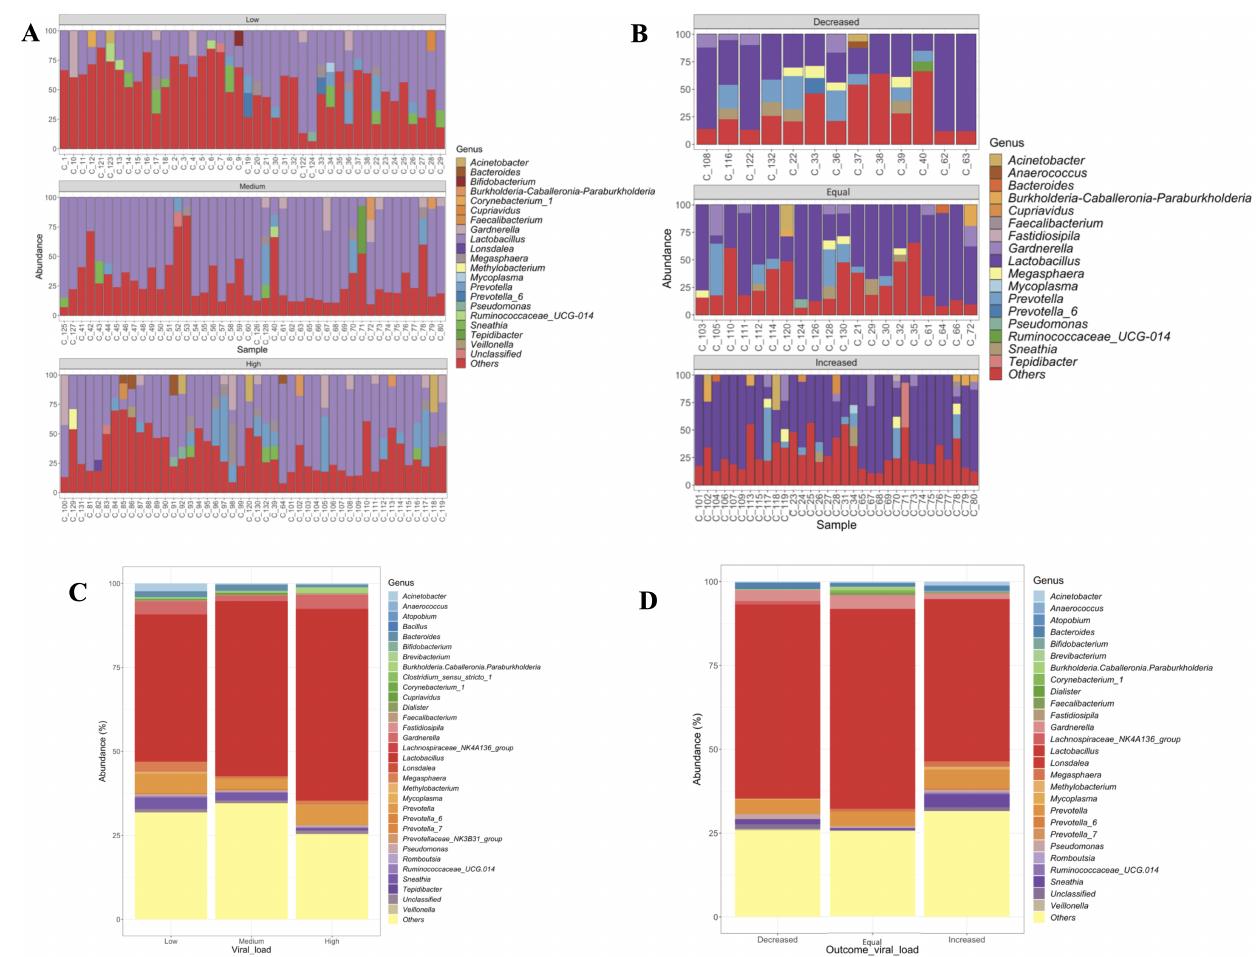
Figure 1. Microbial composition of cervical samples. ( A ) Bar plots showing the main bacterial genera by viral load, considering all the follow-up time points (first and second), and categorizing women according to their VL independent of their follow-up point. ( B ) Bar plots showing the major bacterial genera by viral load outcome. For this figure, the viral load outcome at 12 months is considered. ( C ) Distribution of each bacterial genera by viral load. ( D ) Distribution of each bacterial genera by viral load